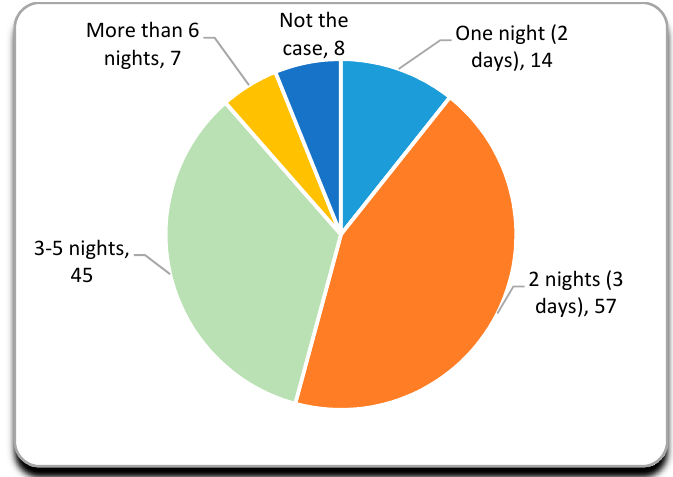
Chart 3. The average length of a holiday in the Romanian mountains .